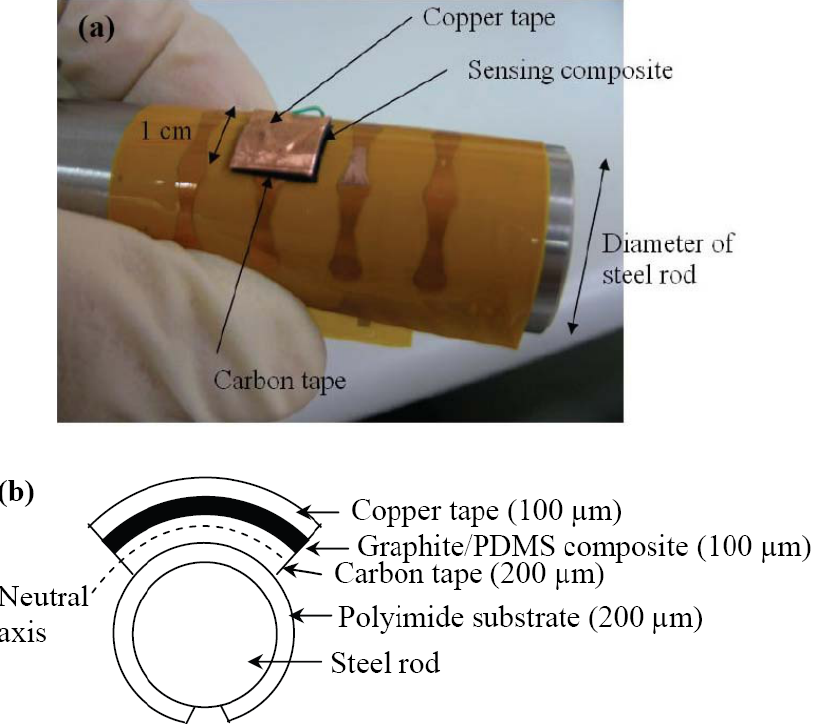
copper tape and a conductive carbon tape on a flexible printed circuit board. Its resistance was then measured on steel rods of different diameters. (a) Photograph of the bending